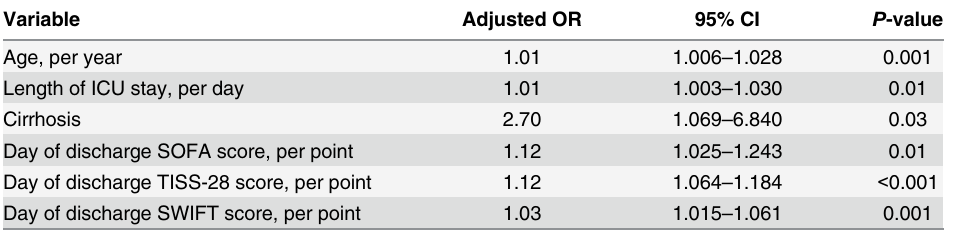
Table 6. Multivariate logistic regression model of factors associated with unplanned intensive care unit (ICU) readmission or death.